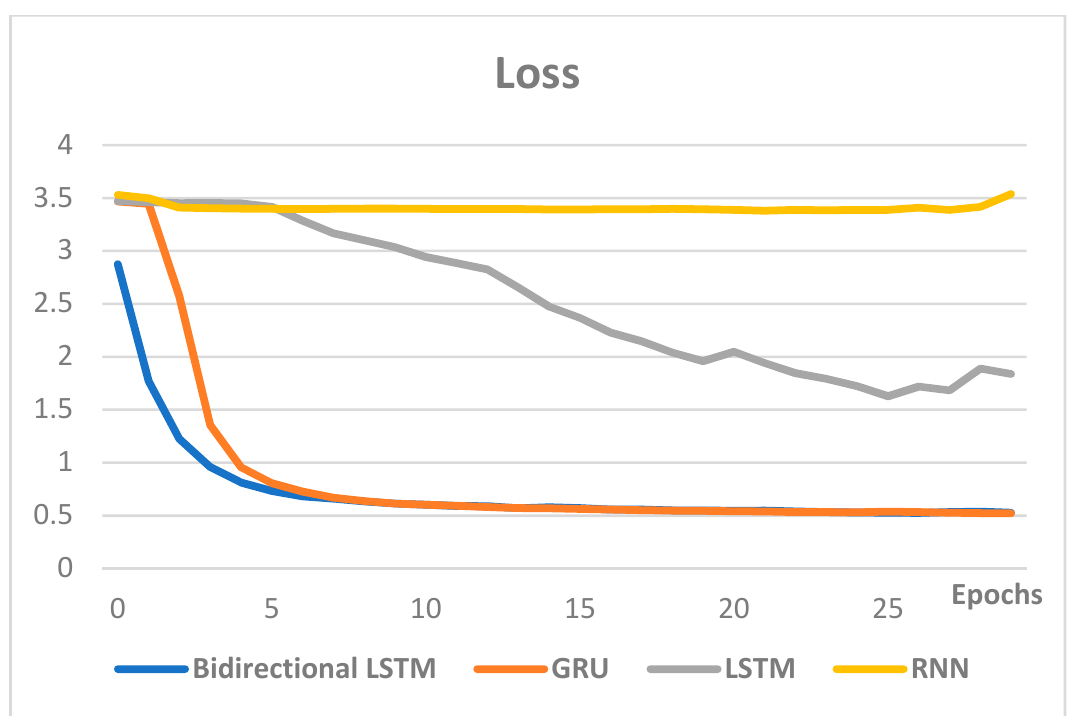
Figure 10. Loss comparison of the RNN-based models. Comparison of the accuracy and loss of the RNN-based models shows that the two indicators are proportional, and the model showing the best performance is